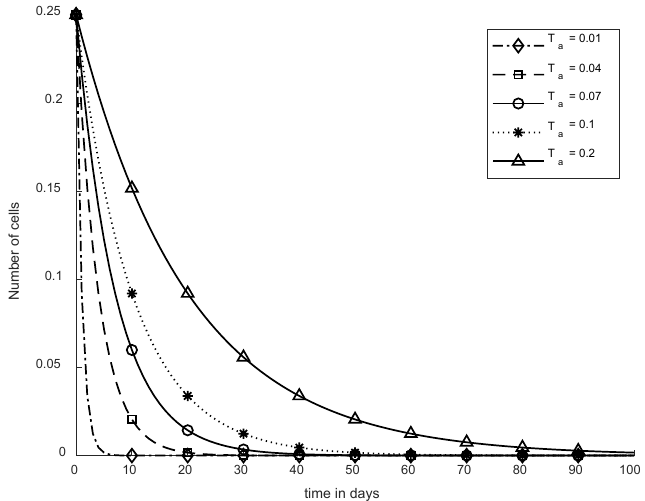
Figure 15. Convergence time of SC.